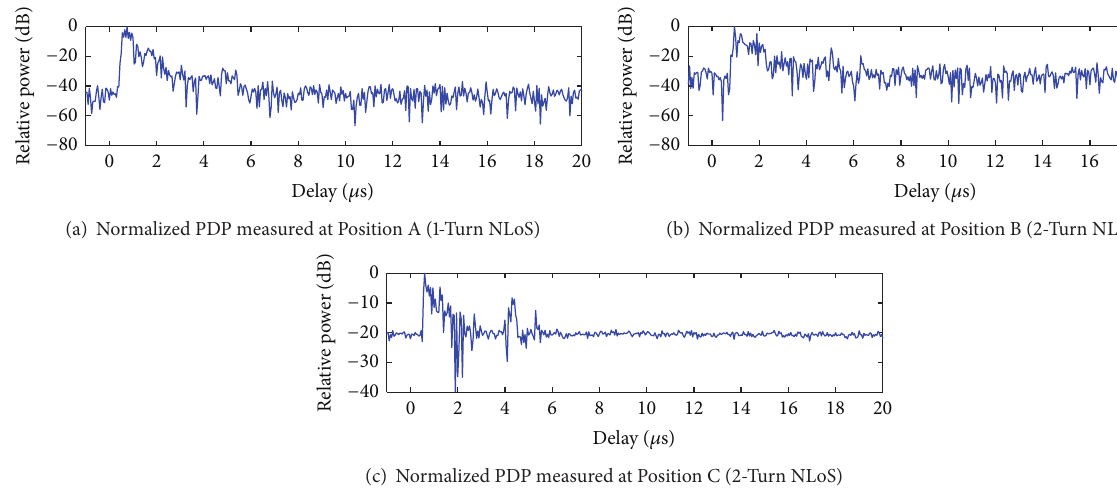
Figure 5: Power delay profile (PDP) measurements between TX and RX positions in Figure